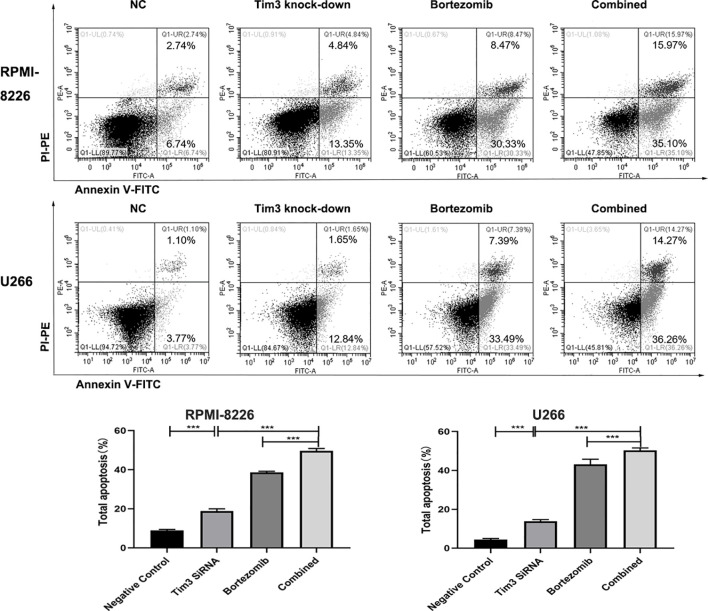
Cell apoptosis in the RPMI-8226 and U266 cell lines detected by flow cytometry using annexin V-Fluorescein isothiocyanate (FITC)/propidium iodide (PI) staining. Shown are average values with standard deviations. Data are performed from 3 independent experiments. *** indicated p<0.001.